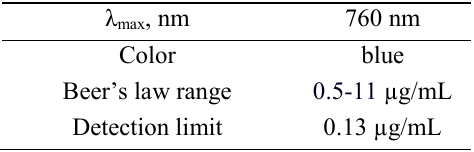
Table 2. Optical characteristics and precision